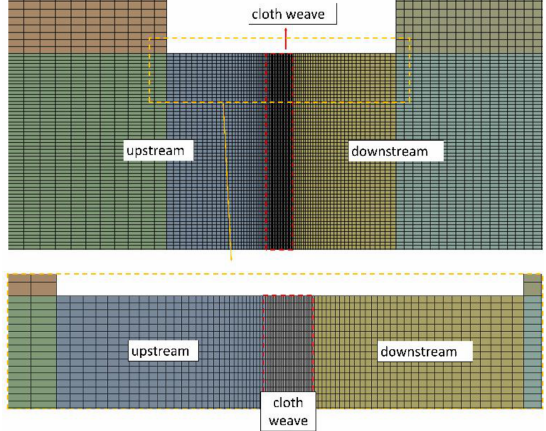
Figure 10. Mesh views for cross